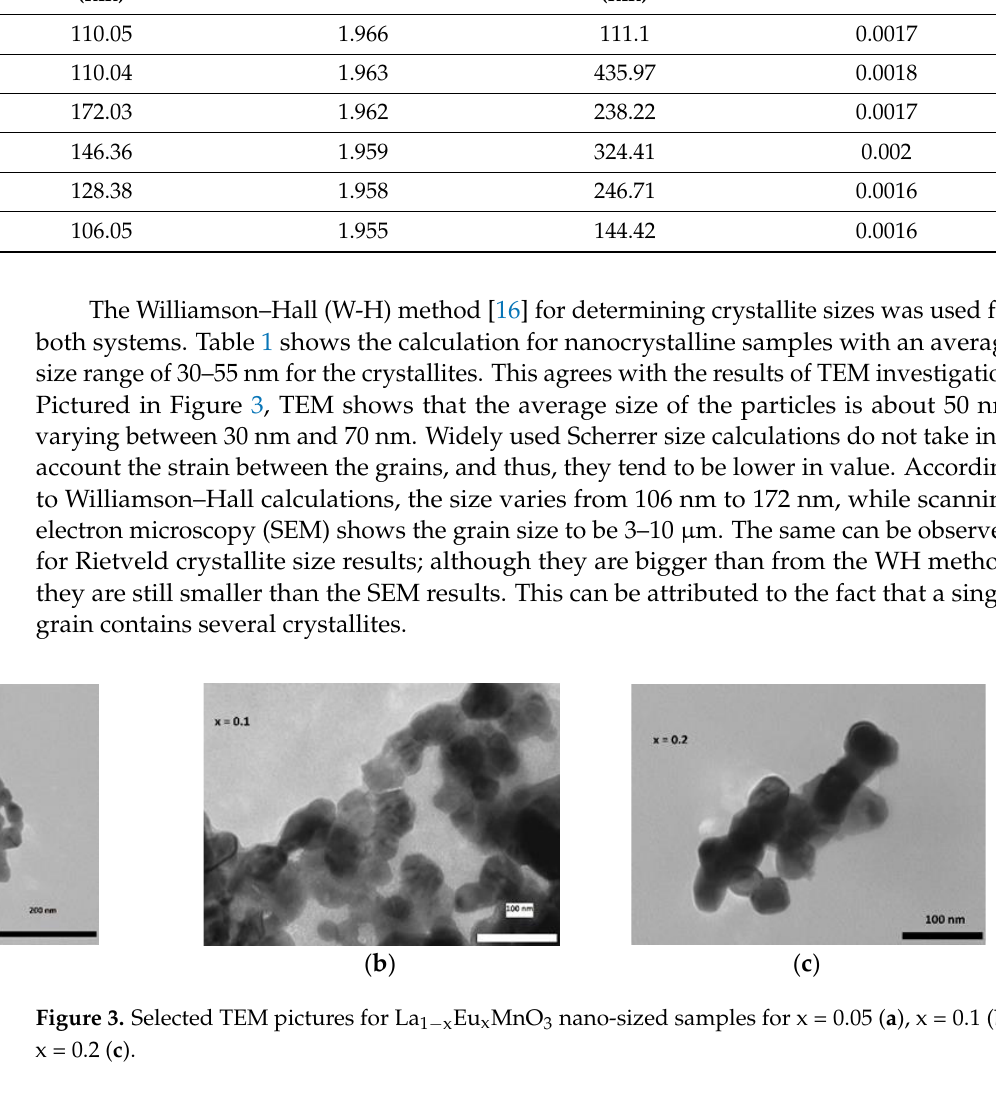
Table 2. Calculated Mn-O lengths and crystallite sizes for polycrystalline bulk samples using the Williamson–Hall and Rietveld methods, including strain values.